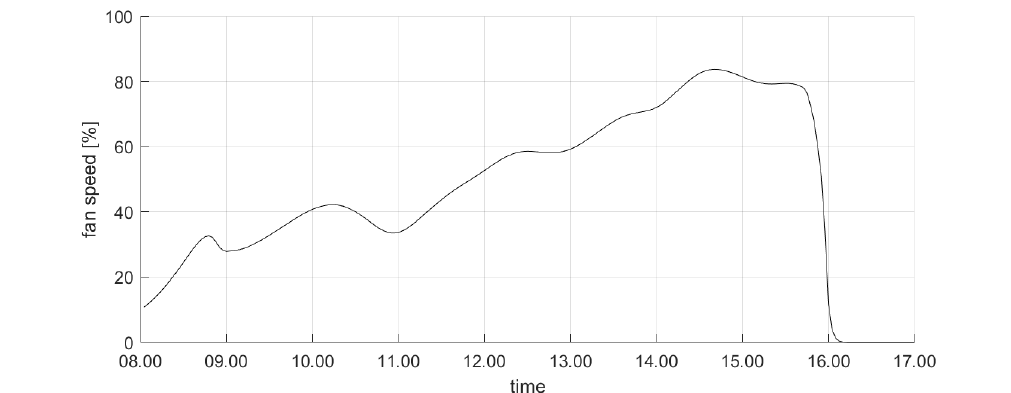
Figure 7. The fan speed profile in the demo site in a midweek day in June